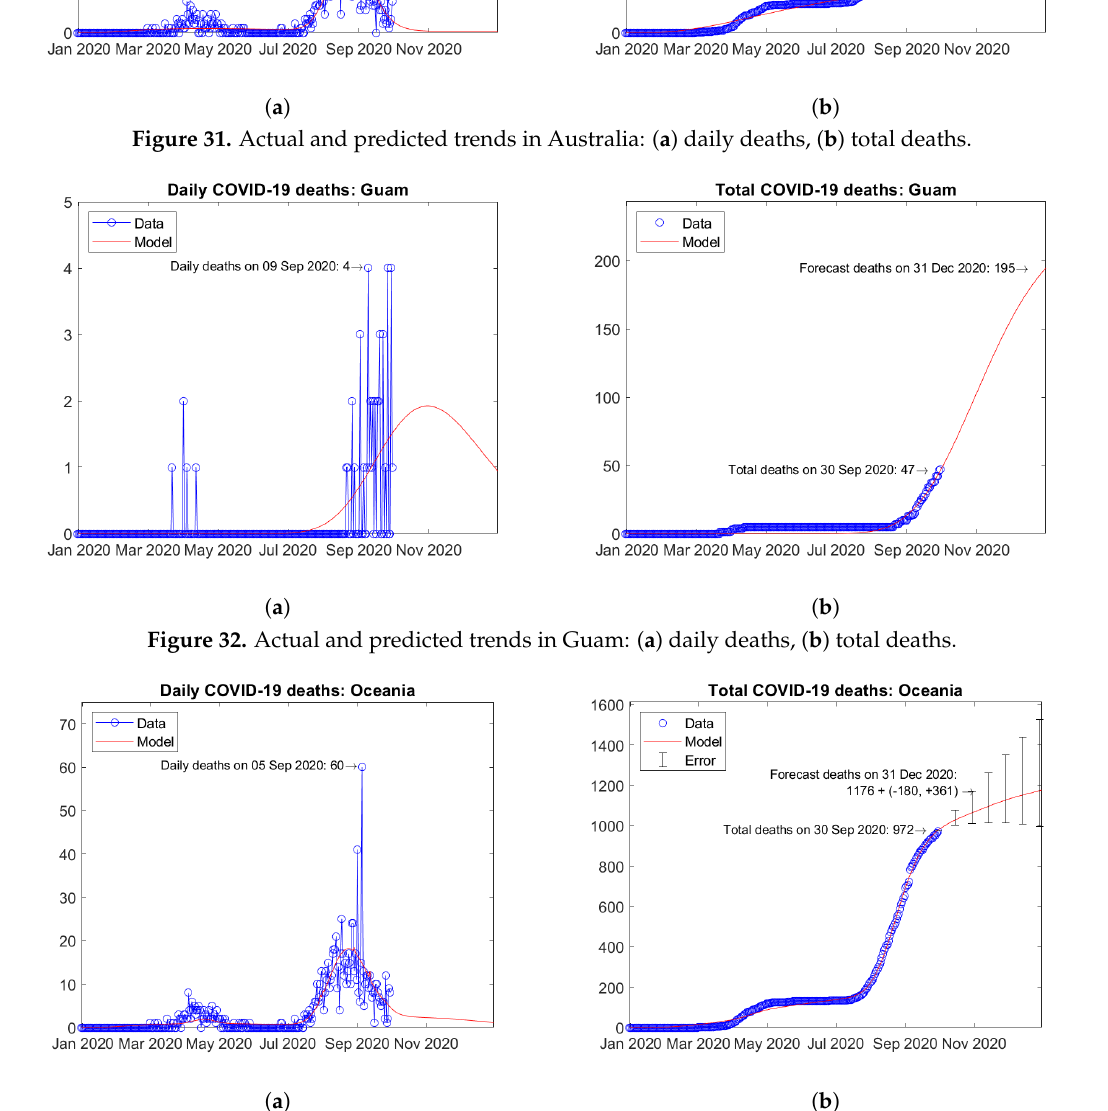
Figure 33. Actual and predicted trends in Oceania: ( a ) daily deaths, ( b ) total